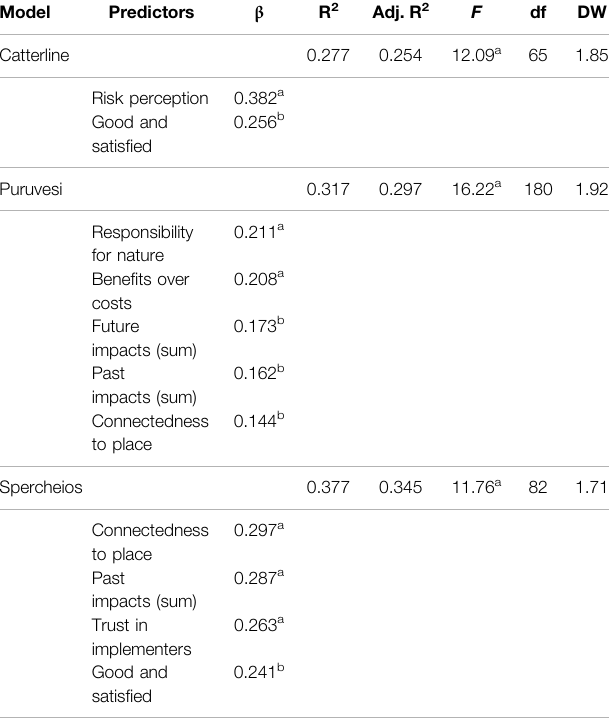
TABLE 6 | Multiple linear regression model results using attitudinal factor scores and risk, nature, and place variables as initial independent variables and behavioral acceptance scores as the dependent variable in each study site. Variables are removed from the model in a step-wise manner in order of least signi fi cant beta per model, until only beta ( β ) coef fi cients at p < 0.05